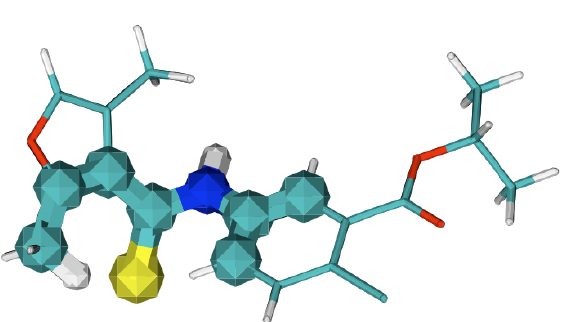
Figure 1: Pattern (wider atoms and bonds) discovered in the DTP AIDS data set using ILP.